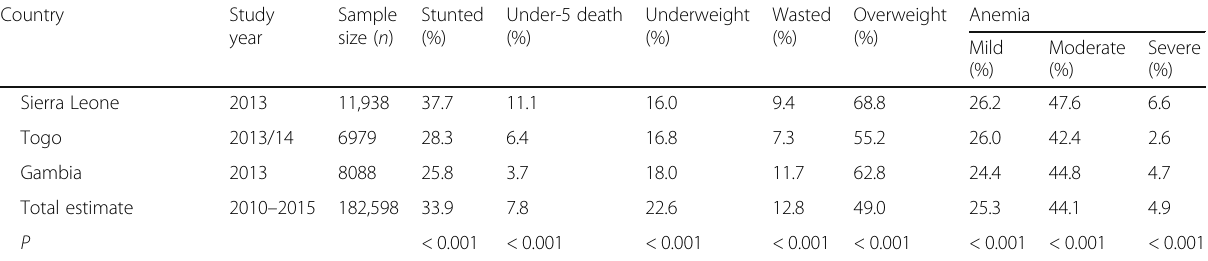
Table 1 Summary statistics from 35 SSA countries on nutrition indicators among under-five children; DHS, 2008-2017 (Continued) Country Study Sample year size ( n